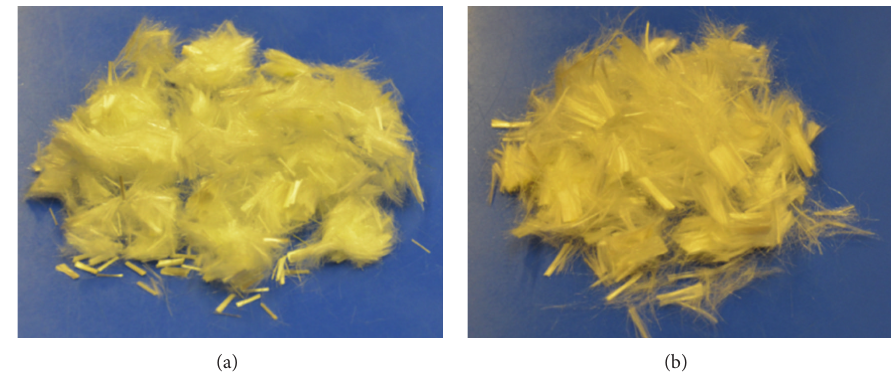
Figure 3: PVA fibres: 6mm fibres and (a) 12mm fibres (b).